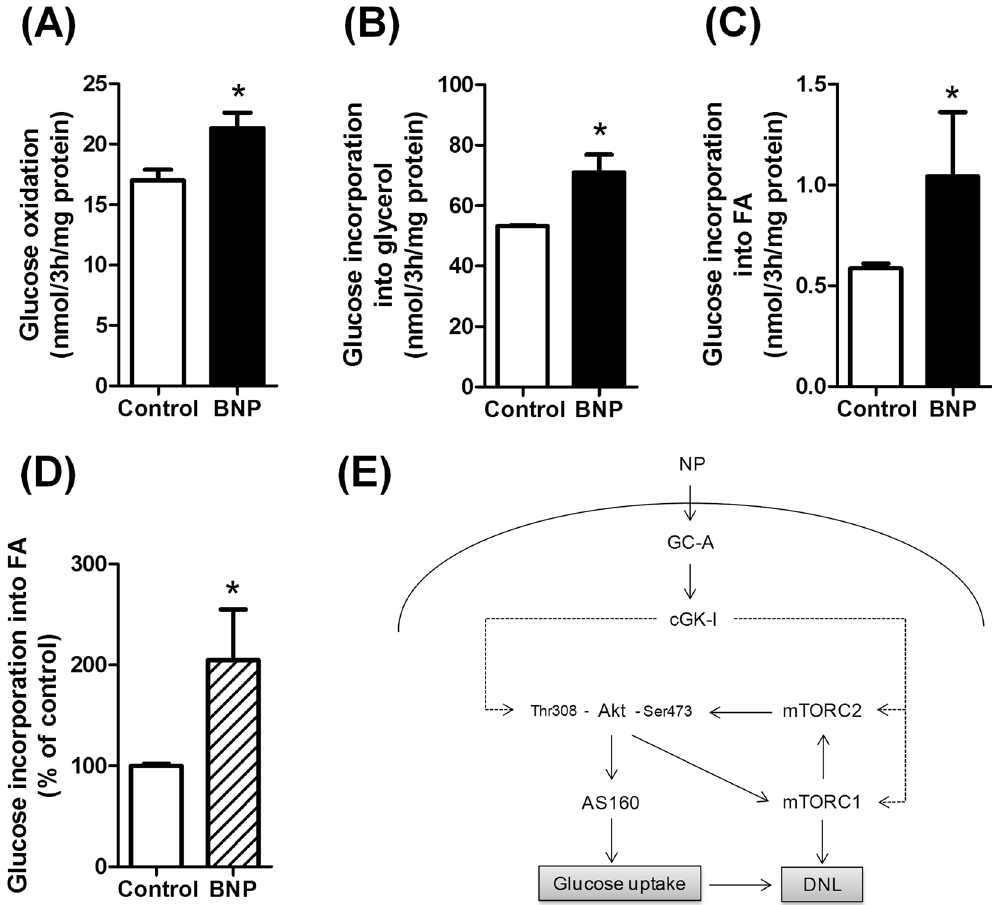
Figure 6. Natriuretic peptides enhance glucose metabolism in human adipocytes. Effect of acute BNP 100 nM treatment on glucose oxidation ( A ), glucose incorporation into glycerol ( B ), and glucose incorporation into fatty acids (FA) ( C ) in hMADS adipocytes. ( D ) Effect of 100 nM BNP on glucose incorporation into FA in human isolated adipocytes. * p < 0.05 vs. control (n = 4–7). ( E ) Schematic model of NP-mediated glucose uptake in human adipocytes. Natriuretic peptides (NP) bind to a transmembrane receptor bearing a guanylyl cyclase activity called GC-A. Binding of NP to GC-A induces the production of cGMP and activation of cGK-I which activate Akt and mTORC2. Activation of mTORC2 phosphorylates Akt at Ser473 and enhances downstream signalling to the Rab-GTPase AS160 which promotes membrane GLUT4 translocation and glucose uptake. NP therefore promote glucose uptake and enhance glucose incorporation into glycerol and FA pools through de novo